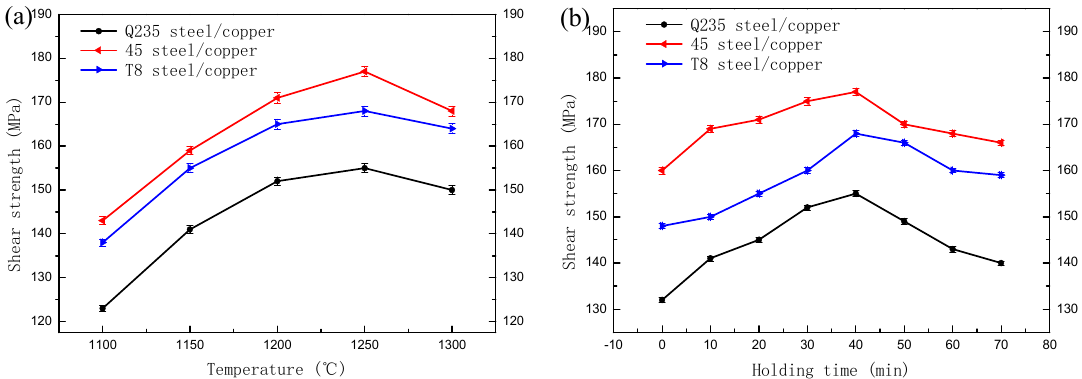
Figure 4. Shear strength of the steel and copper bimetallic casting at different temperatures and holding times in the solid–liquid compound casting process: ( a ) different temperatures and ( b ) different holding times.